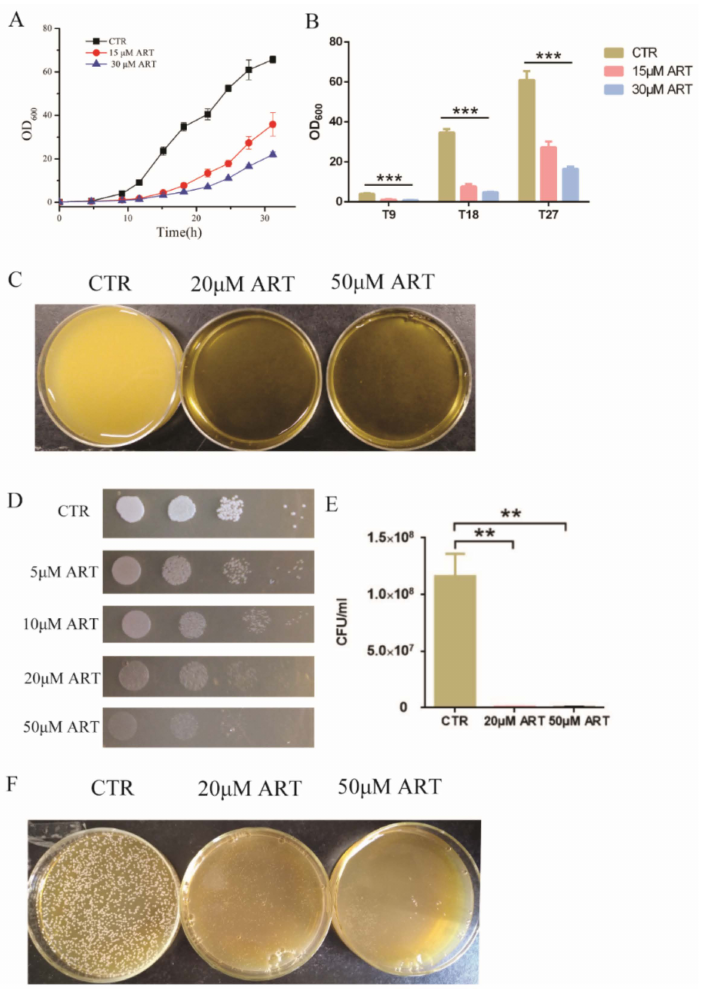
Figure 2. Artemisinin is active against C. glabrata . ( A ) The growth curve of C. glabrata with artemisinin. DMSO was used as a negative control (CTR). Data are mean ± SD of three independent